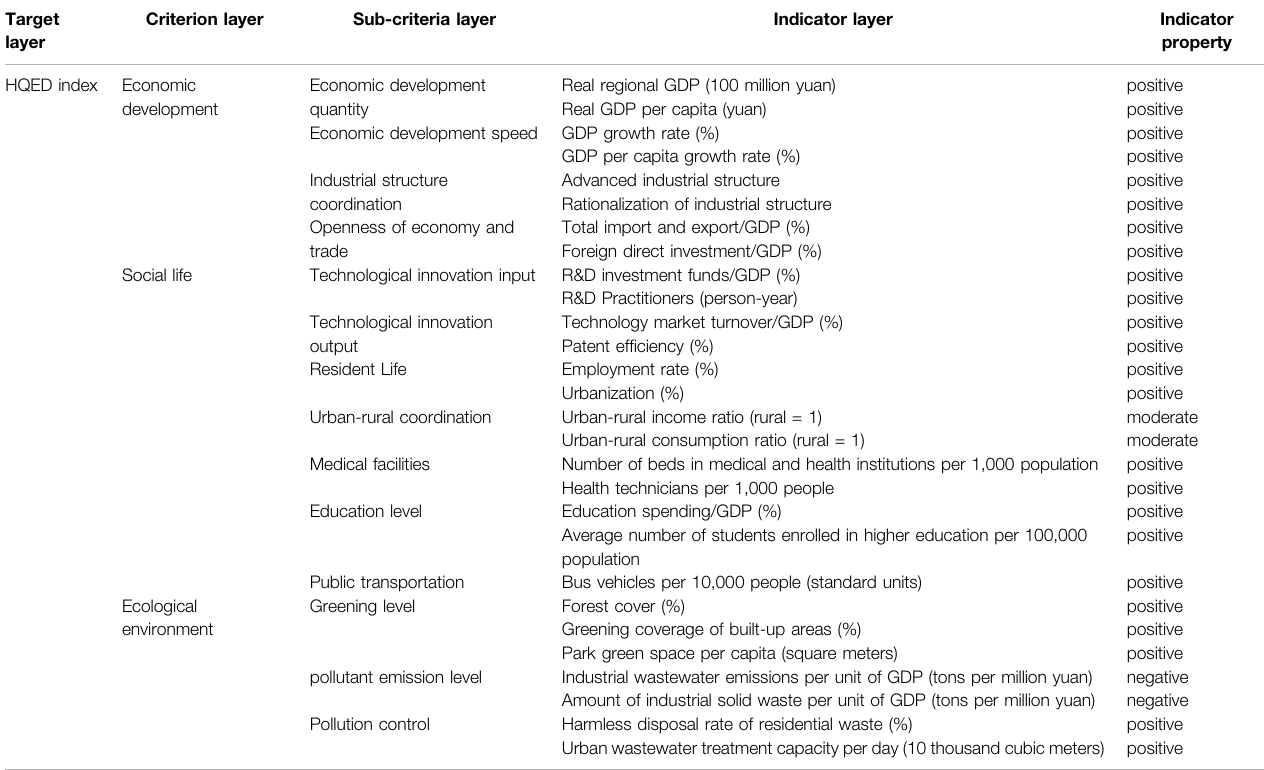
TABLE 1 | Evaluation index system of China ’ s HQED